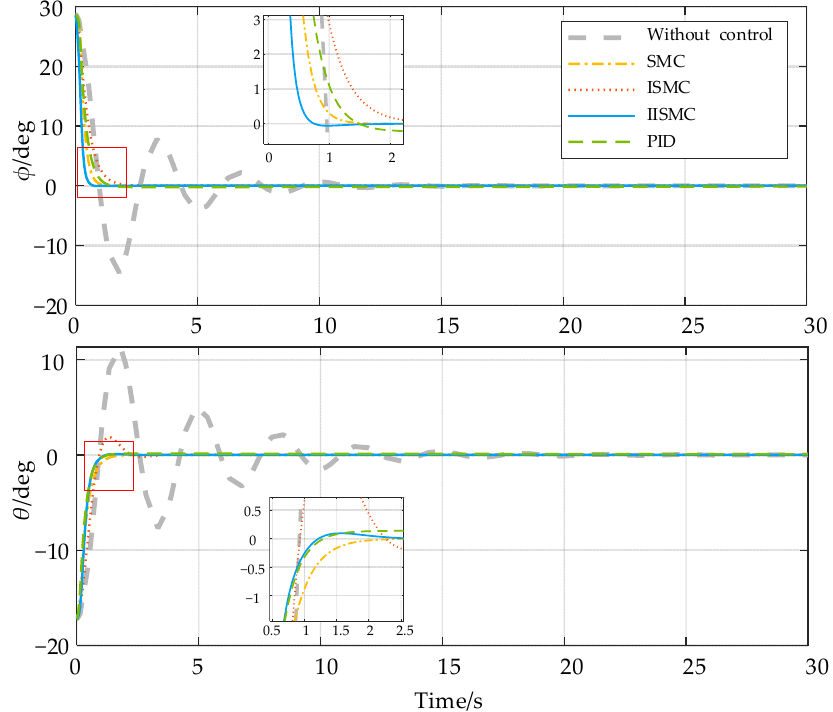
Figure 8. Attitude angles under four control schemes in Scene 1.